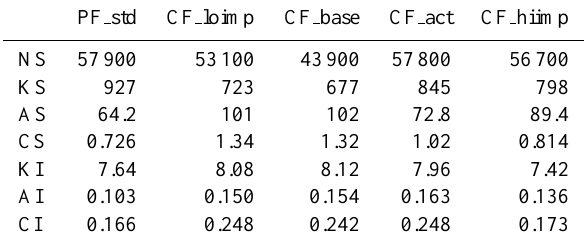
Table 6. Global and annual mean aerosol number burdens (10 10 m − 2 ) for the five simulations presented in Table 1 and for the seven lognormal modes, NS: nucleation soluble, KS: Aitken soluble, AS: accumulation soluble, CS: coarse soluble, KI: Aitken insoluble, AI: accumulation insoluble, CI: coarse